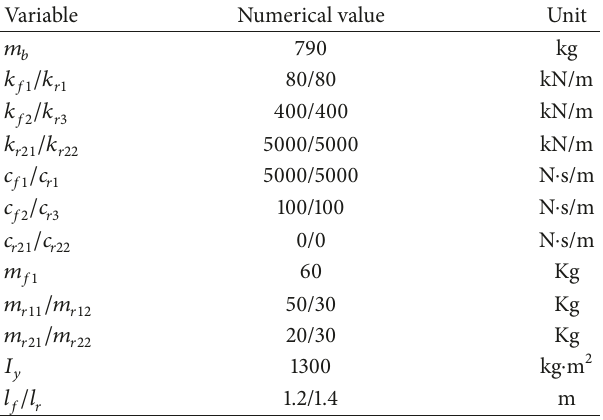
Table 1: Vehicle